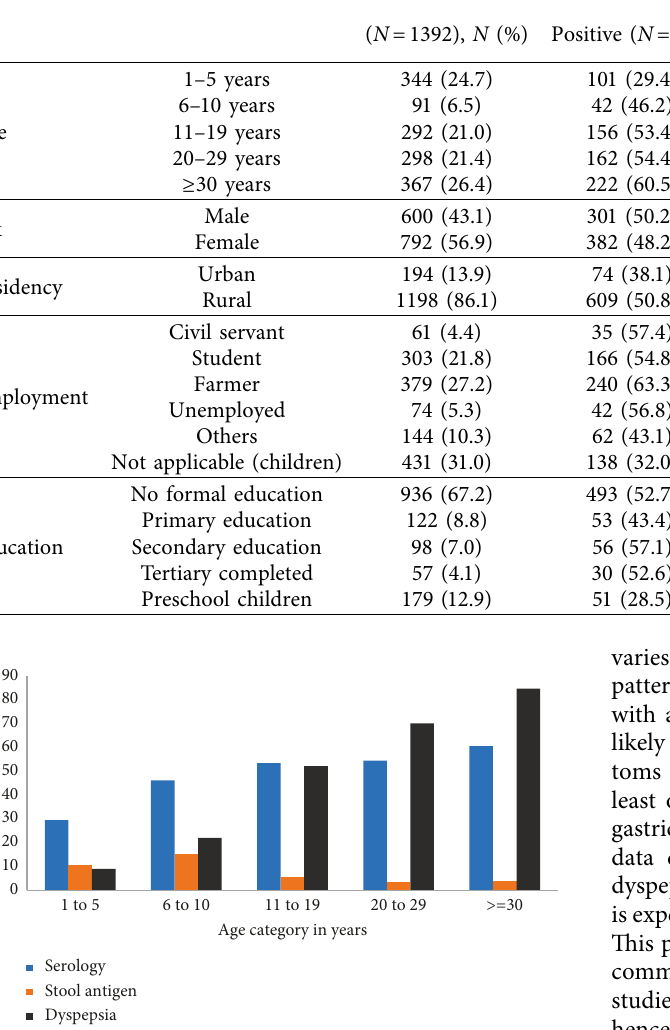
Figure 1: Prevalence of H pylori infection, by serology and stool antigen test, and symptoms of dyspepsia by age group. “Dyspepsia” on the graph refers to the presence of one or more of the dyspepsia